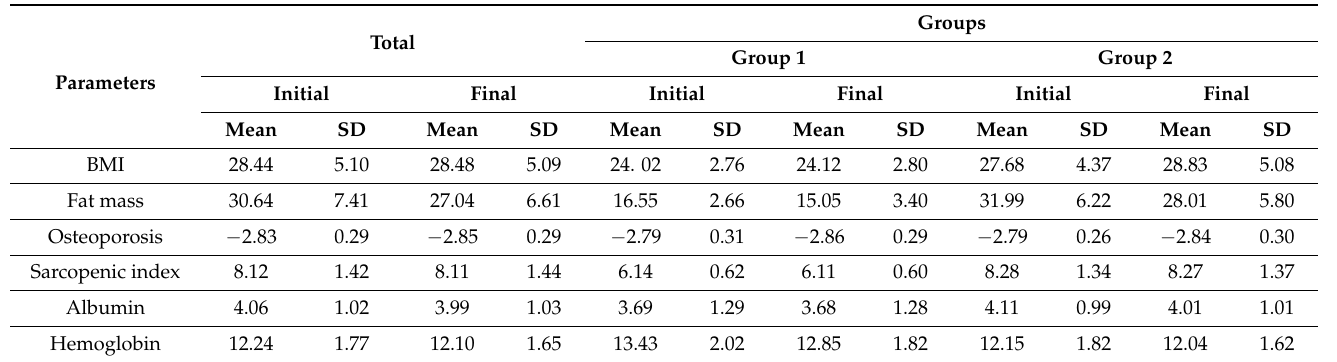
Table 2. The initial values of the research parameters at the level of the cohort and in both